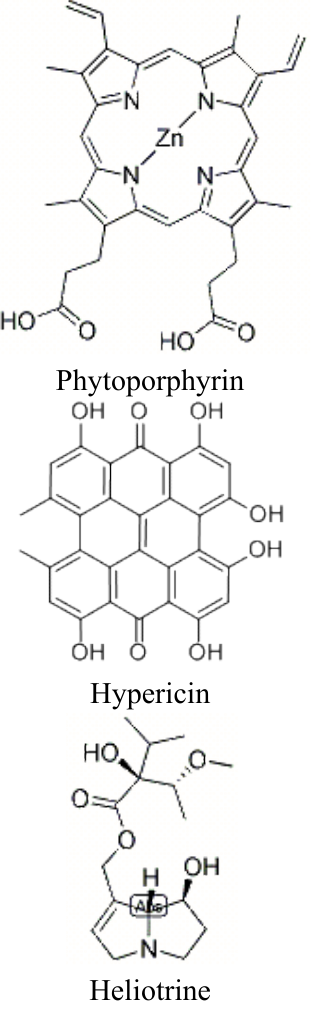
Figure 2. Selected chemical structures of SPPs causing photosensitization in grazing livestock, clockwise from upper left to right. Phytoporphyrin is a microbially produced breakdown product of chlorophyll. Echimidine is produced by Echium plantagineum . Angelicin is produced by Heracleum mantegazzianum . Diosgenin is produced by Panicum virgatum . Chlorophyll A is produced by all green plants. Dehydroretronecine is produced by Senecio spp. Heliotrine is produced by Heliotrope spp. Hypericin is produced by Hyperacum perforatum